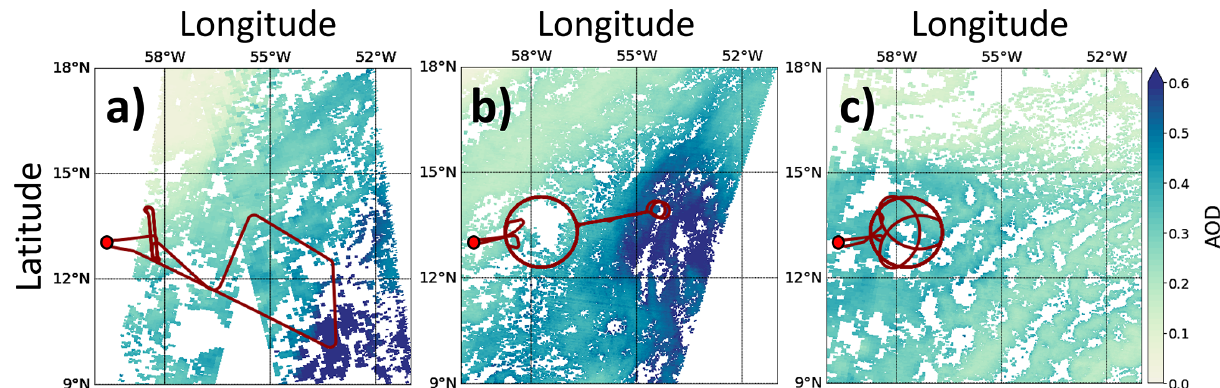
Figure 2. The HALO flight tracks of the three research flights over long-range-transported Saharan dust aerosol on 30 January 2020 (a) , 31 January 2020 (b) and 2 February 2020 (c) on top of MODIS (Moderate Resolution Imaging Spectroradiometer) satellite imagery of aerosol optical depth (AOD) at 550nm. All MODIS images were taken between 14:00 and 18:00UTC. The Grantley Adams International Airport on Barbados is marked with red dots. Table 1. Overview of the conducted research flights over Saharan dust aerosol during EUREC 4 A in 2020 including dates, times of take-off and landing, total duration as well as number of launched dropsondes (times given in UTC; note: Atlantic Standard Time = UTC − 4). ID Date Take-off Landing Duration Sondes HALO-0130 30 Jan 11:19 15:09 04:50h 4 HALO-0131 31 Jan 14:07 00:10 ( + 1d) 10:03h 74 HALO-0202 02 Jan 11:28 20:15 08:47h